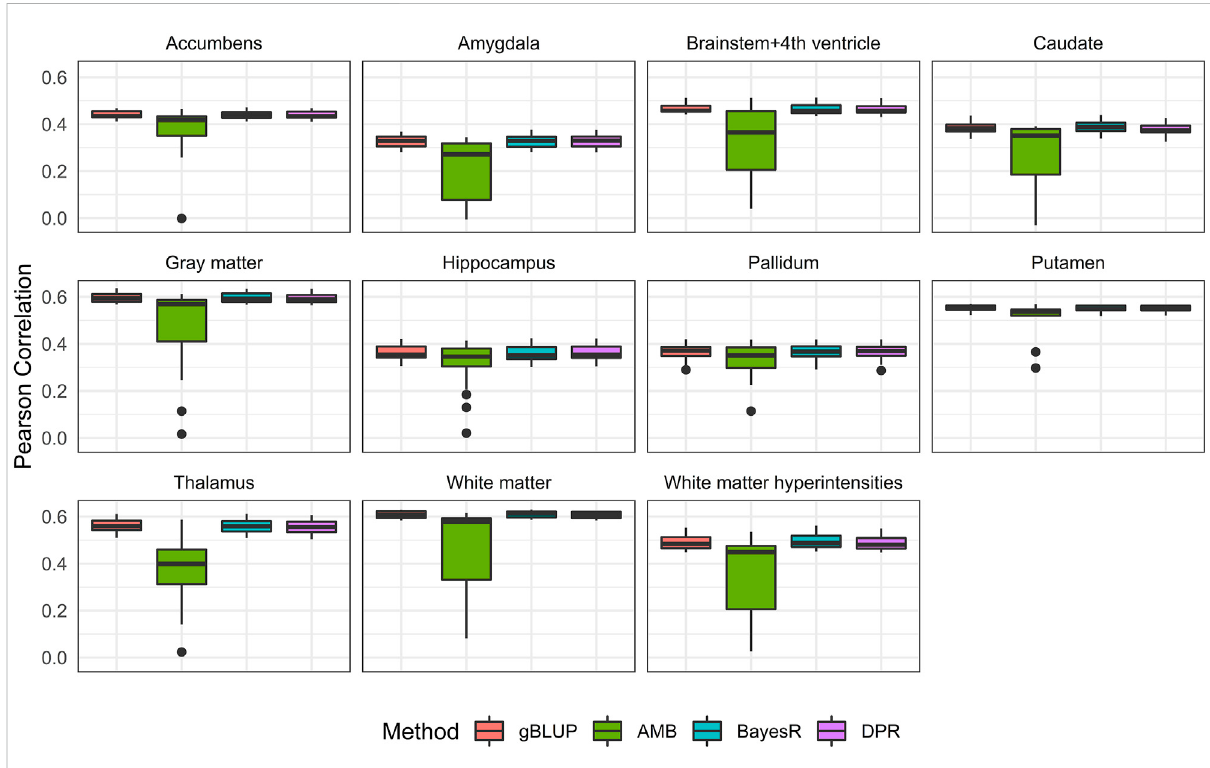
FIGURE 5 Pearson correlation foreleven brainimagingtraits thatare predicted usinggenetic variantsanddemographicvariables (age, sexandeducation) intheUKBdata.Methodsincludegenomicbestlinearunbiasedprediction(gBLUP),adaptiveMultiBLUP(AMB),thelatentDirichletprocessregression (DPR) and BayesR.